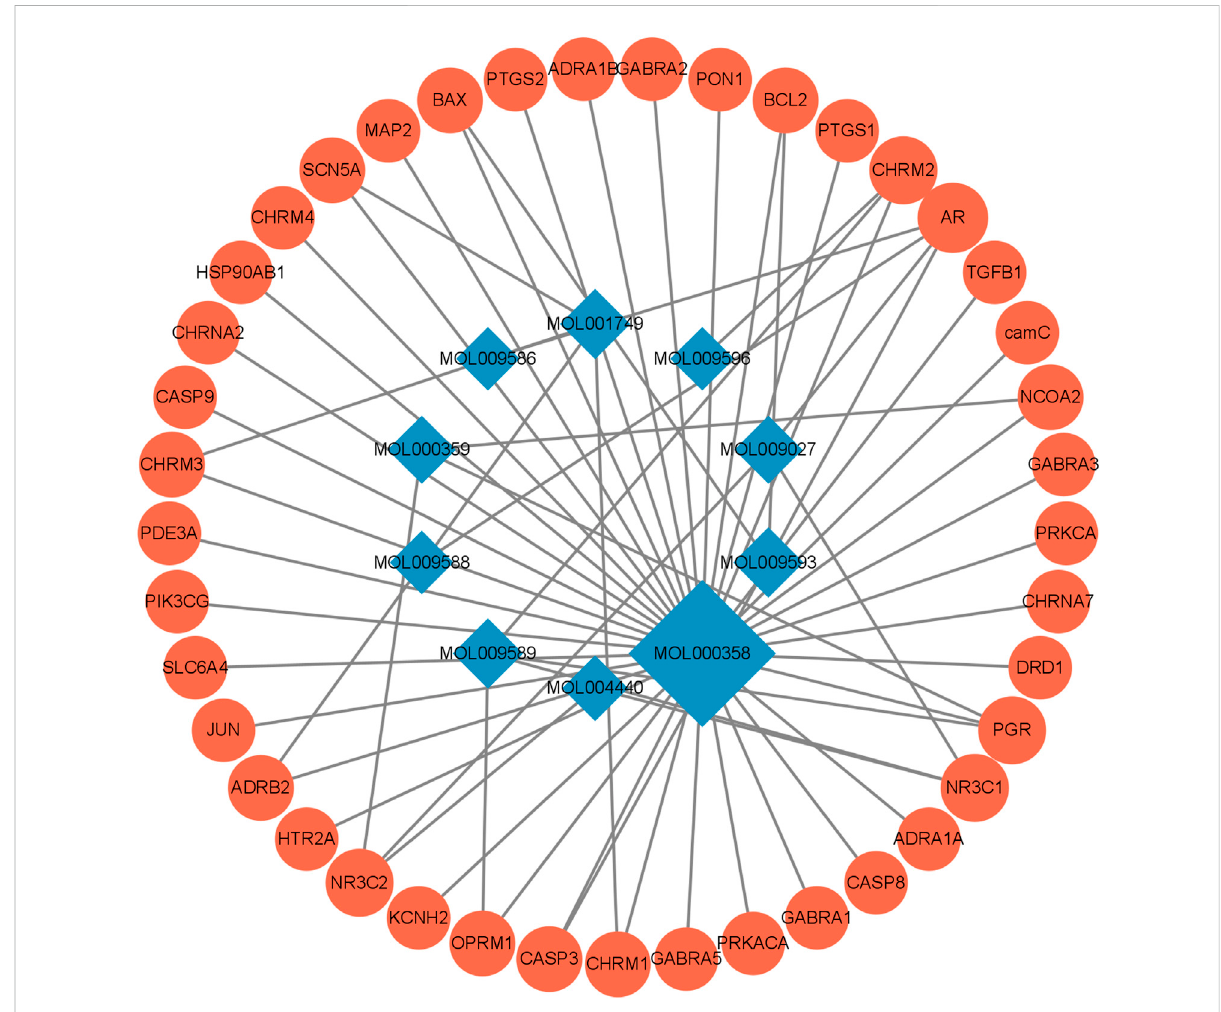
FIGURE 3 Compound-Target Network. The blue diamond represents the active compound contained in FIB. The orange circle represents the